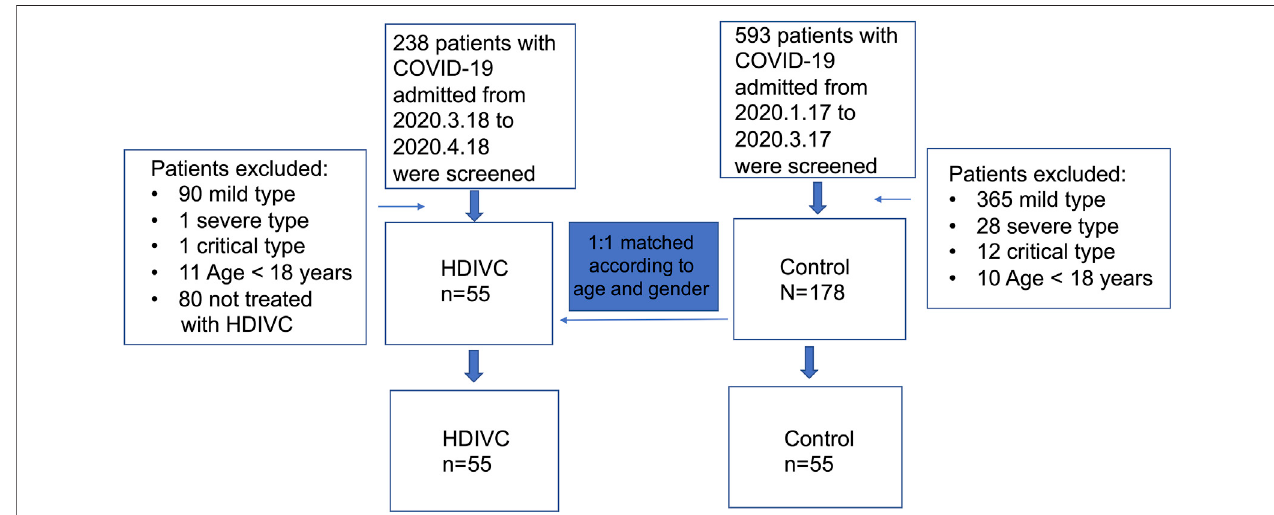
FIGURE 1 | Study fl owchart. HDIVC, high dose intravenous vitamin C; COVID-19, coronavirus disease 2019.